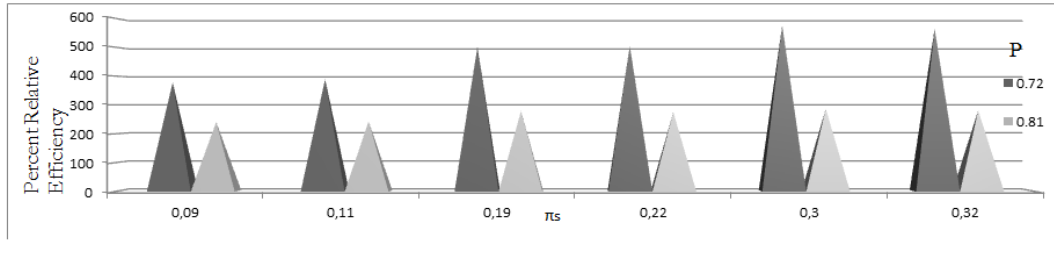
Figure 2 – Percent relative efficiency of the proposed estimator (under proportional allocation) with respect to th estimator (under proportional allocation i.e. Hong et al.’s (1994)